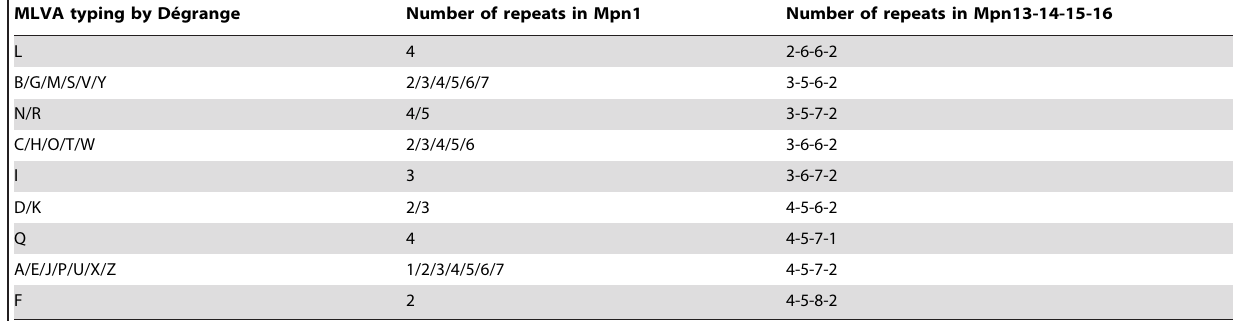
Table 3. VNTRs (Mpn13, 14, 15, 16) in 26 genotypes